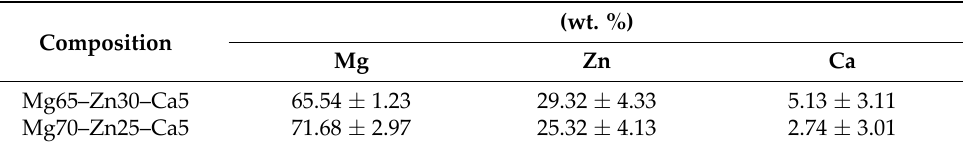
Figure 4. SEM-EDS micrographs of ( a ) Mg65–Zn30–Ca5 and ( b ) Mg70–Zn25–Ca5 milled for 20 h. Table 2. Quantitative elemental analyses (wt.%) of Mg65–Zn30–Ca5 and M70–Zn25–Ca5 milled for 20 h, measured using SEM-EDS.